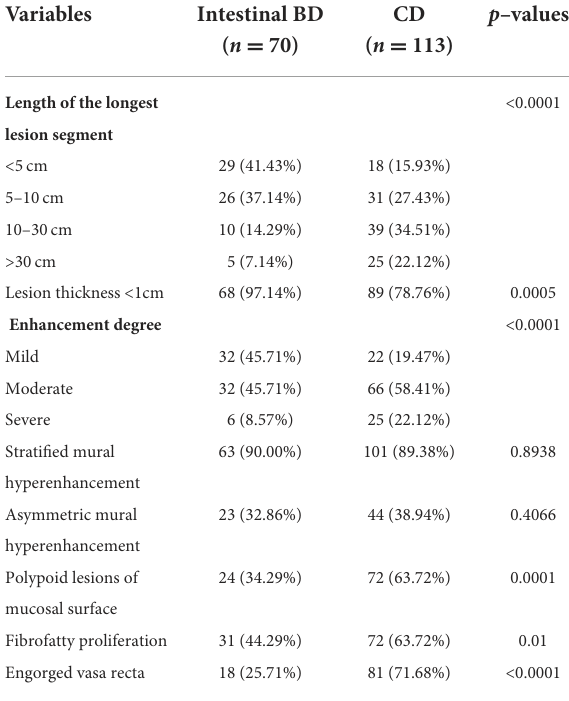
TABLE 5 CTE characteristics of participants with CD or intestinal